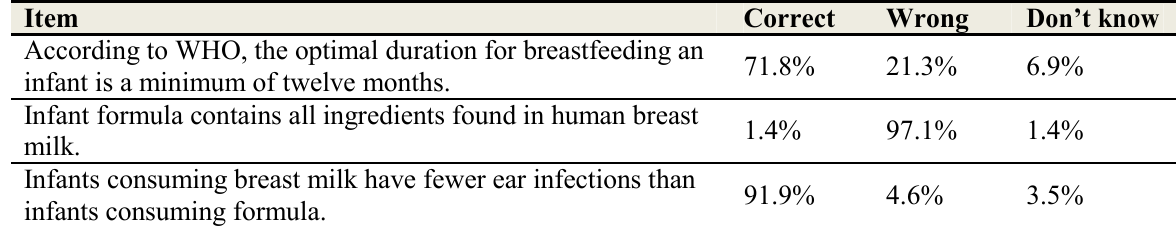
Table 2. Students’ knowledge on infant feeding